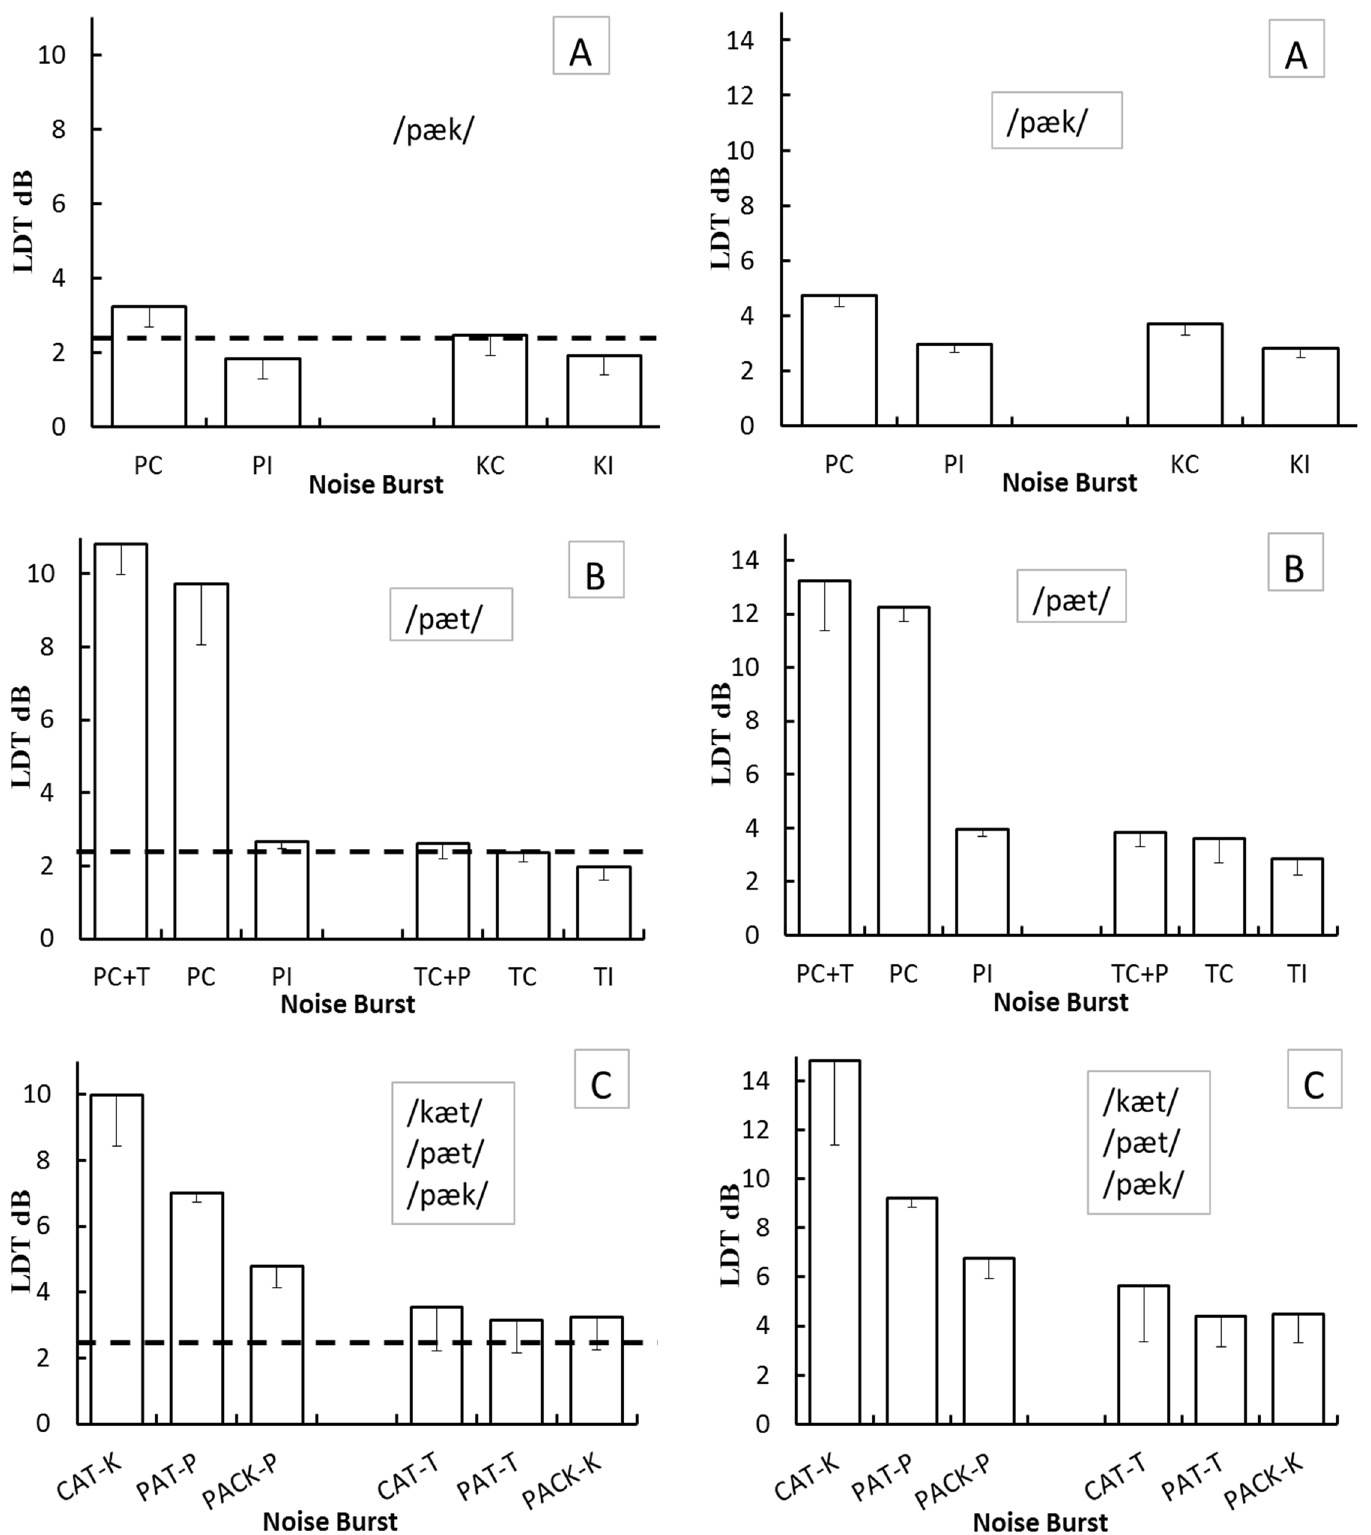
Fig 3. Level Discrimination Thresholds (LDTs). The LDTs (Y axis) measured in experiment 1 with the words /pæk/ and /pæt/ are depicted in the top (A) and middle panels (B), respectively; the bottom panels (C) depict the LDTs measured in experiment 2. Panels on the left- and right-hand side depict LDTs estimated at the 0.75 and